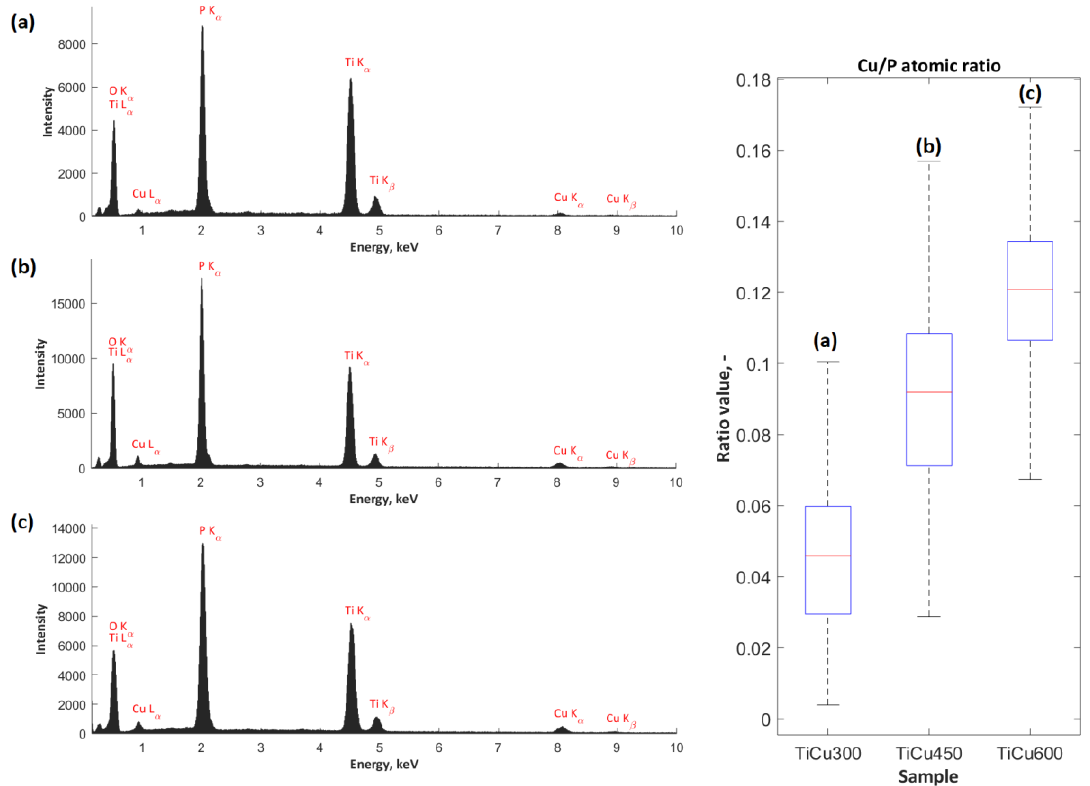
Figure 3. The EDS spectra of PEO coatings (left side) and corresponding copper-to-phosphorus (Cu / P) ratios (right side) of the three coatings: TiCu300 ( a ), TiCu450 ( b ), and TiCu600 ( c ).